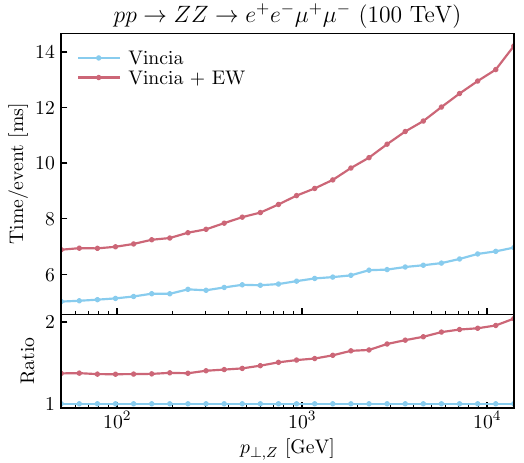
Figure 15: Relative time consumption to generate pp → ZZ → e + e − µ + µ − at 100 TeV as a function of p ⊥ , without EW shower (blue) and with EW shower (red). , Z Tests were performed on a single M1 Pro core with clang version 13.0.0 with -O2